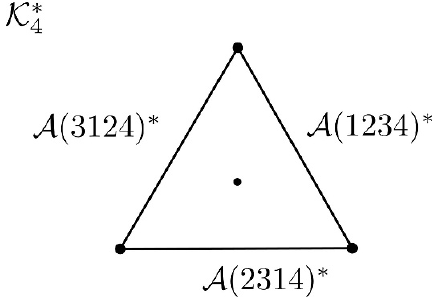
Figure 7 . The three dual associahedra A ( (cid:11) ) (cid:3) canonically embedded in K (cid:3)